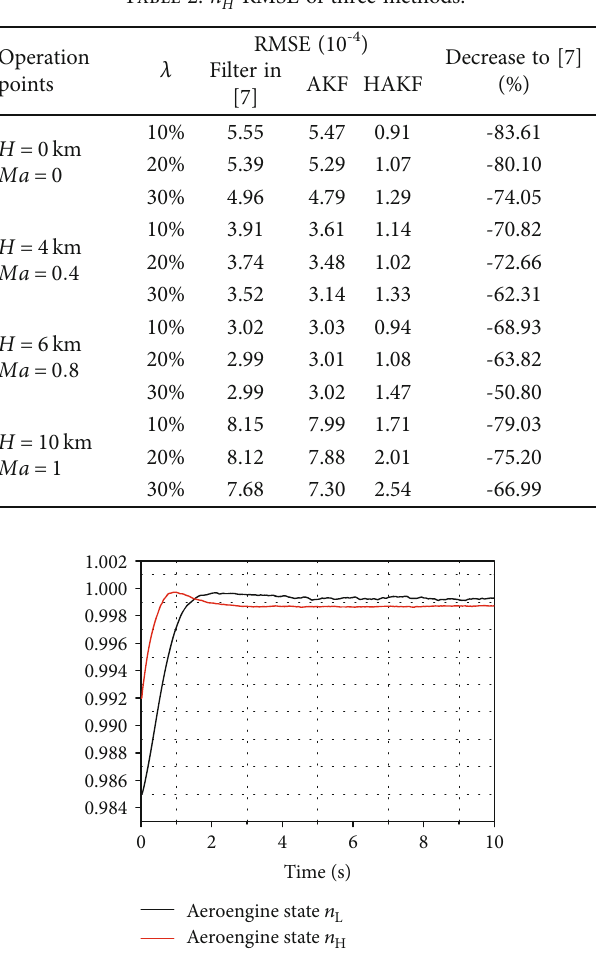
Table 2: n H RMSE of three methods.